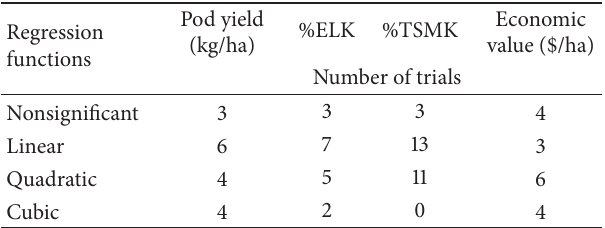
Table 2: Frequency of significant regressions ( 𝑃 ≤ 0.05 ) for pod yield, percentages of extra large kernels (%ELK) and total sound mature kernels (%TSMK), and economic value versus days after peanut emergence for 17 trials from 2003 to